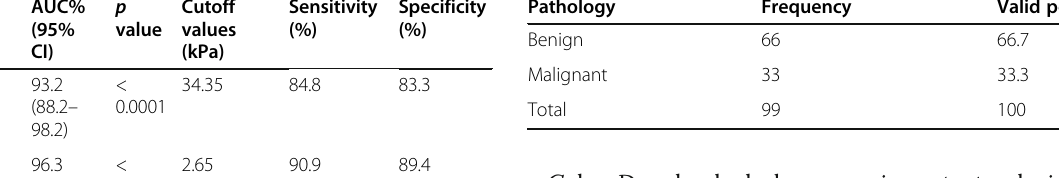
Table 4 Showing diagnostic performance of SWE parameters Elasticity indices